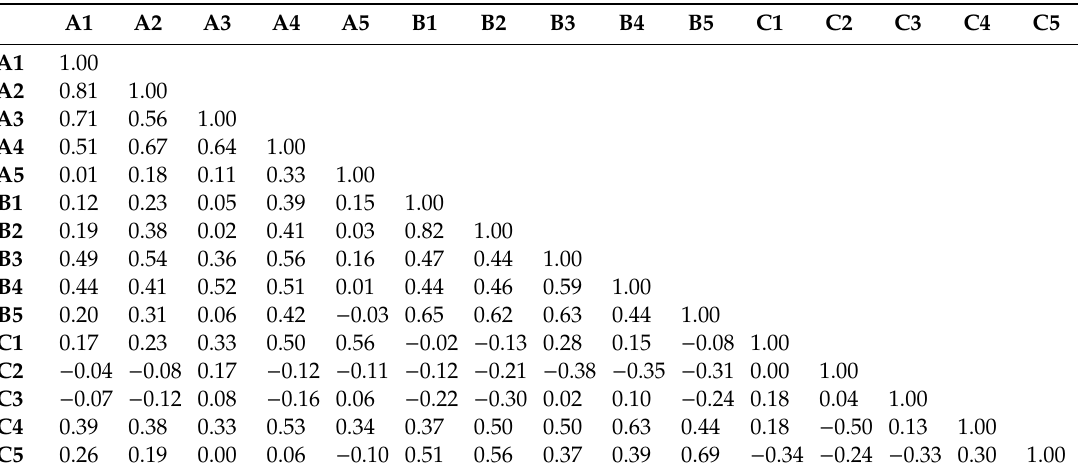
Table 3. Correlation matrix between individual questions (own study).